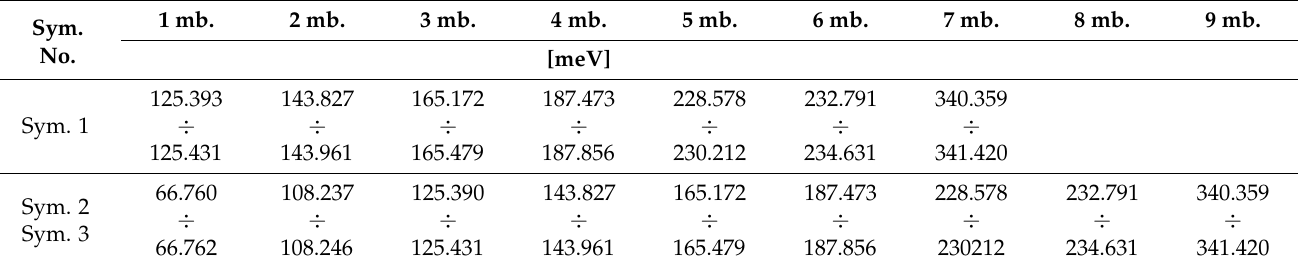
Table 3. Allowed minibands calculated for structure reported in [28] by using the BM method (Sym. 1) and MBM method (Sym. 2 and Sym. 3).